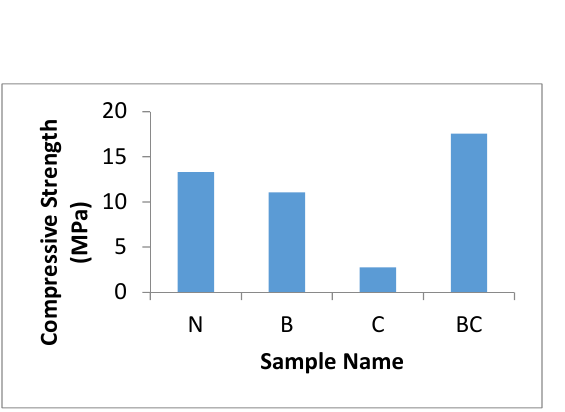
Fig. 13: Bar Chart of Strength